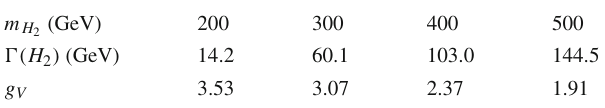
half of the SM Higgs boson mass (same as H 1 mass) while below half of the H 2 mass (thus tion of SDM will be suppressed by the propagator at larger t and that of FDM/VDM will be peaked at m H